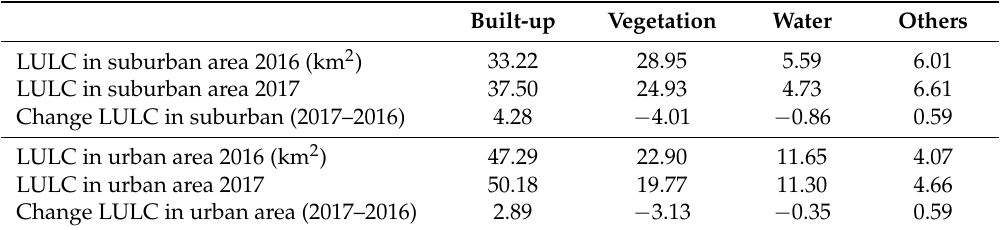
Table 9. Land use/land cover (LULC) change in urban and suburban areas of Hanoi in 2016–2017. Built-up Vegetation Water